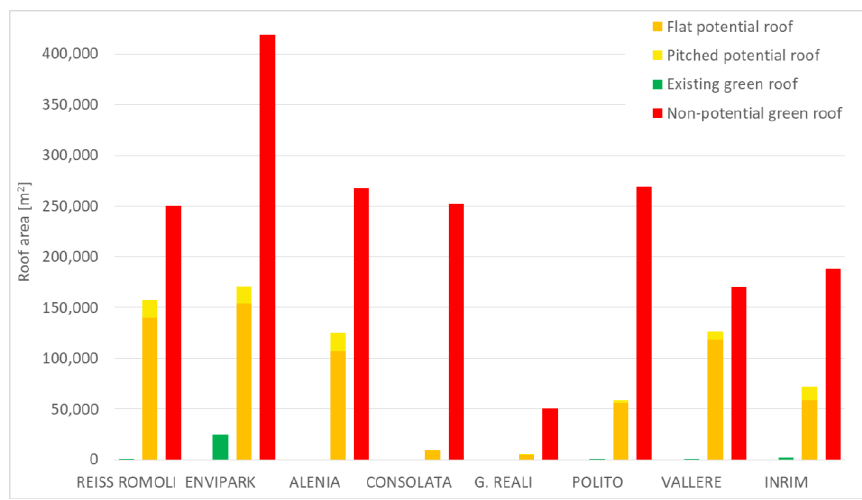
Figure 16. Identification of the existing and potential green roofs in eight areas of Turin. Table 9. Identification of existing and potential green roofs in the eight areas of Turin.